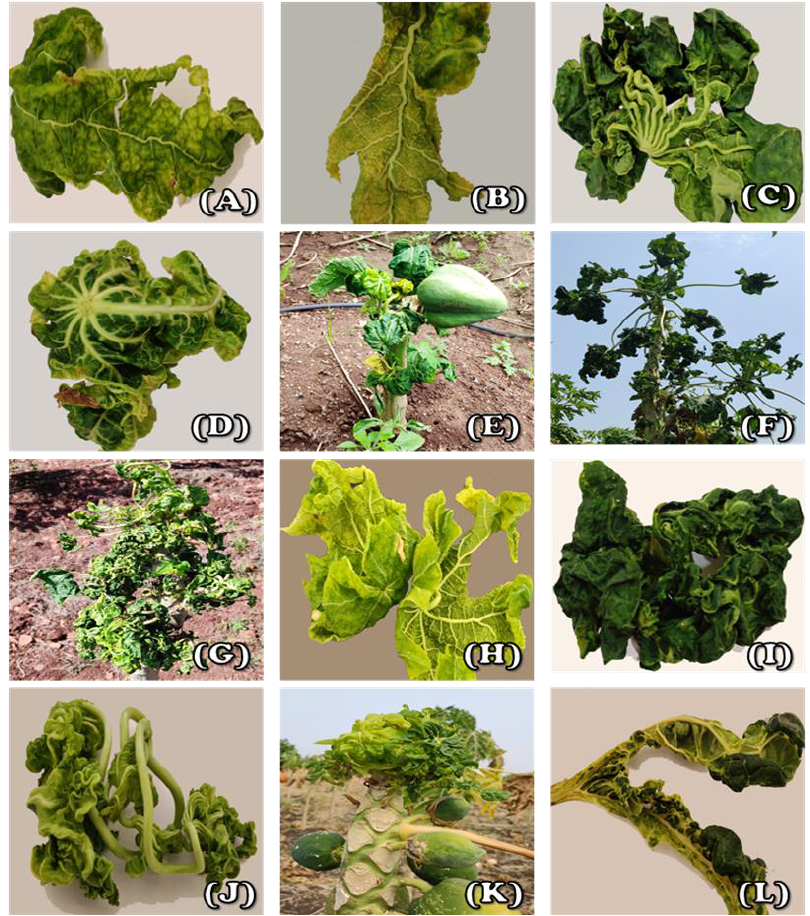
Figure 1. Begomovirus infected papaya plants showing different symptoms under field conditions: ( A ) Vein clearing; ( B ) Vein thickening; ( C ) Zigzag vein; ( D ) Vein enation; ( E ) Leaf rolling; ( F )